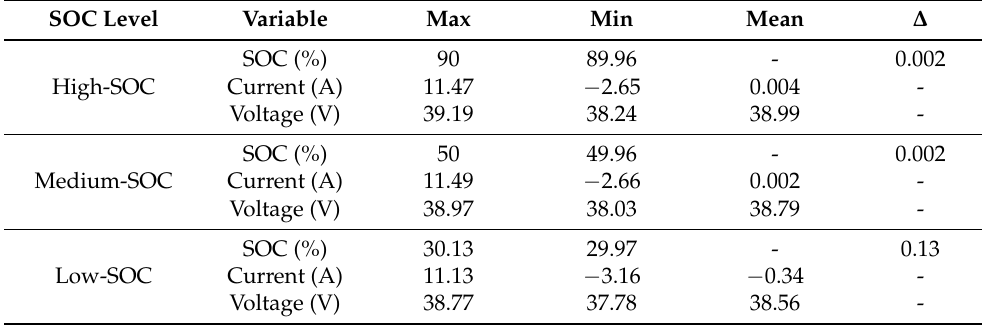
Table 9. Battery response in high, medium and low SOC full-active hybrid simulation.